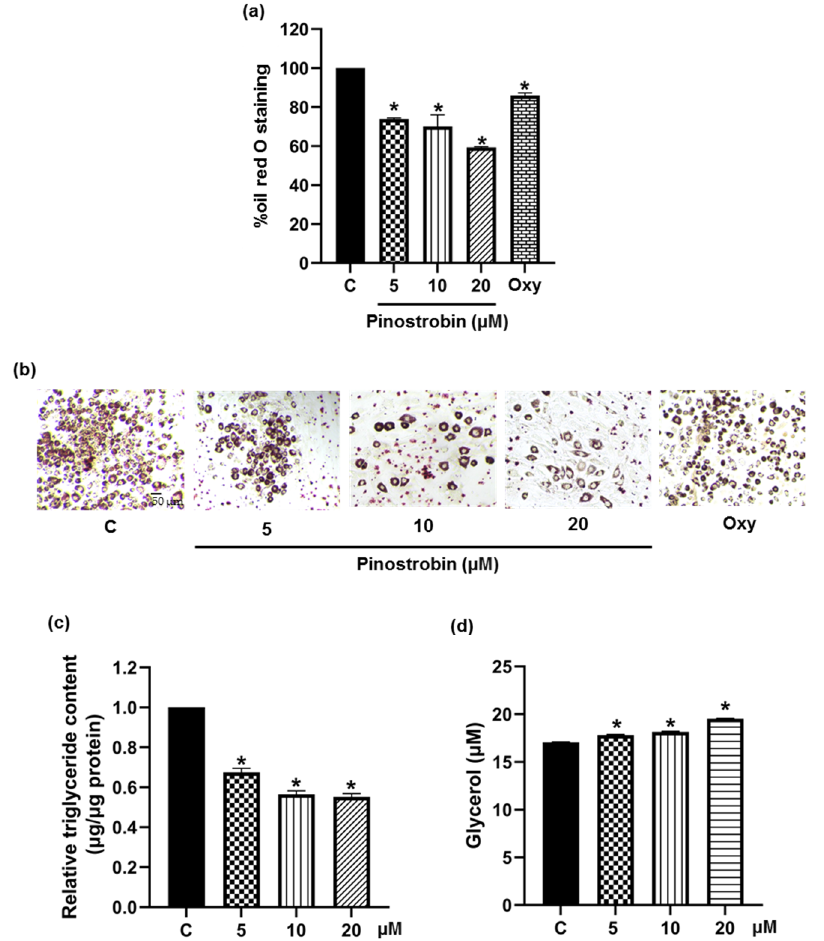
Figure 3. Suppressive effect of pinostrobin on adipogenesis was evidenced by the lower levels of ( a ) cellular lipid content presented as % oil red O and ( b ) cellular lipid droplets stained with oil red O in differentiated 3T3-L1 cells treated with 5–20 µM pinostrobin for 48 h. Oxyresveratrol (Oxy) at 5 µM was used as positive control. ( c ) A decrease of cellular triglyceride content and ( d ) an increase of extracellular glycerol level was detected in pinostrobin treated-3T3-L1 cells. Data represent mean ± SD (n = 3). * p < 0.05 compared with vehicle control cells (C) treated with 0.5% DMSO.